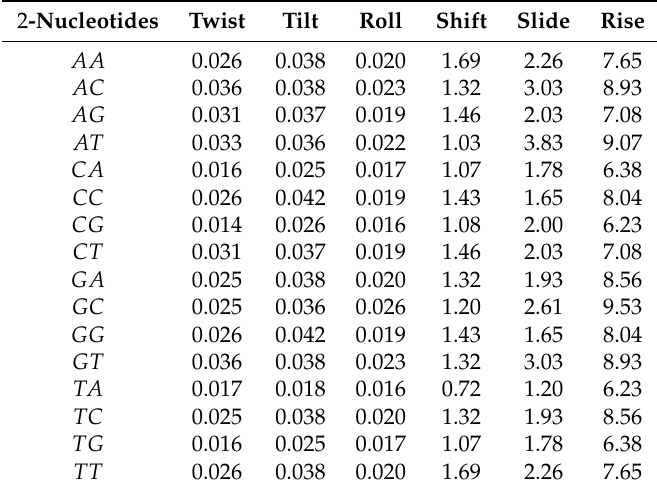
Table 1. The original values of six physical structural properties. 2